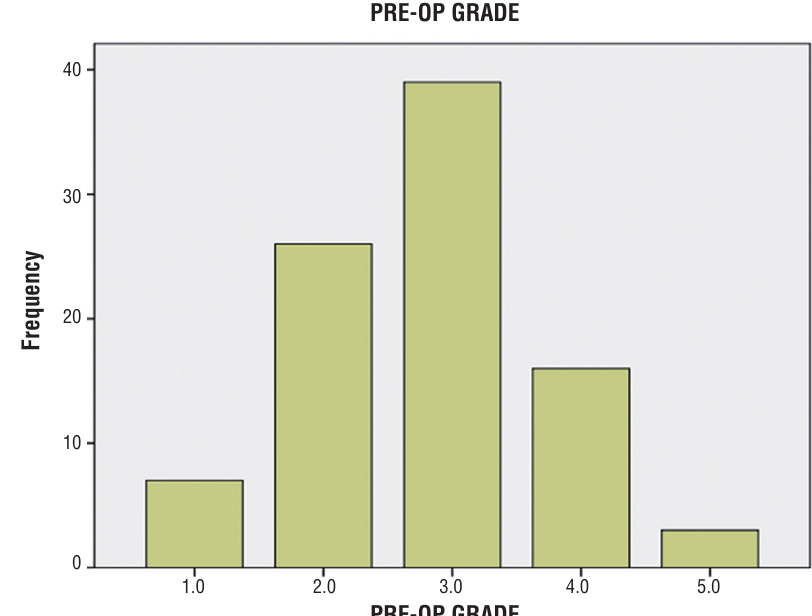
Figure 2 - Distribution of preoperative